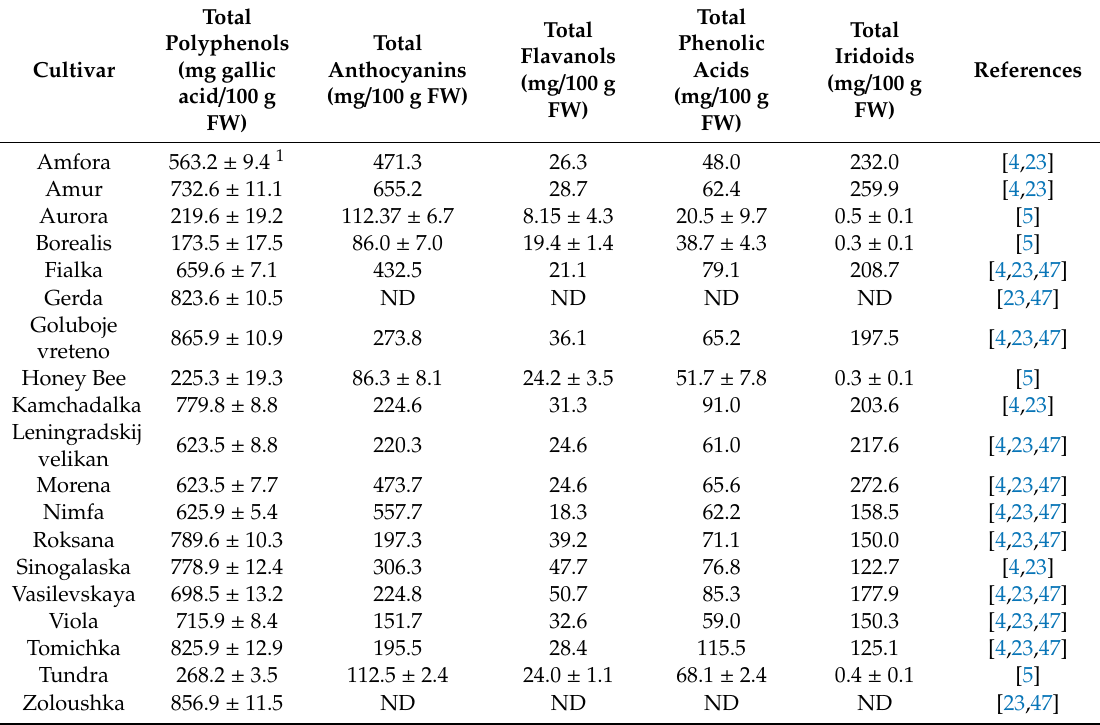
Table 1. Di ff erent polyphenol contents in analyzed cultivars of honeysuckle berry (ND—no data and FW—fresh